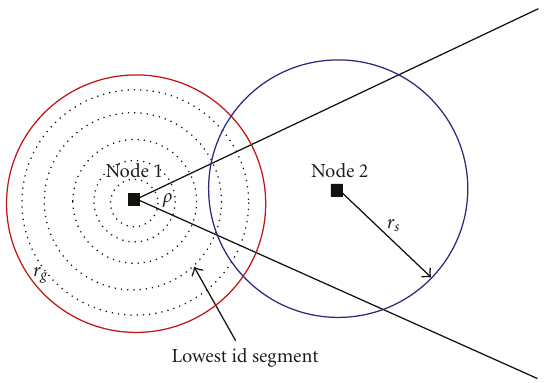
Figure 6: An example where the sensing region of nodes are divided into n G = 6 segments. The covered portion of each segment by neighboring nodes is represented with an angle. In the figure, ρ corresponds to the covered portion of the lowest id segment, Sl 5 , of node 1’s sensing region by its neighboring node